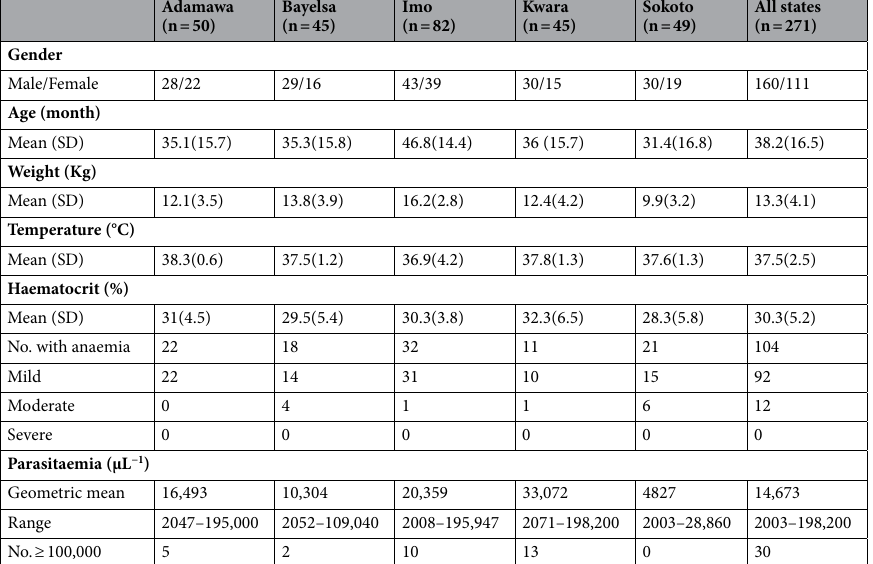
Table 1. Demographic and clinical features of children with uncomplicated Plasmodium falciparum